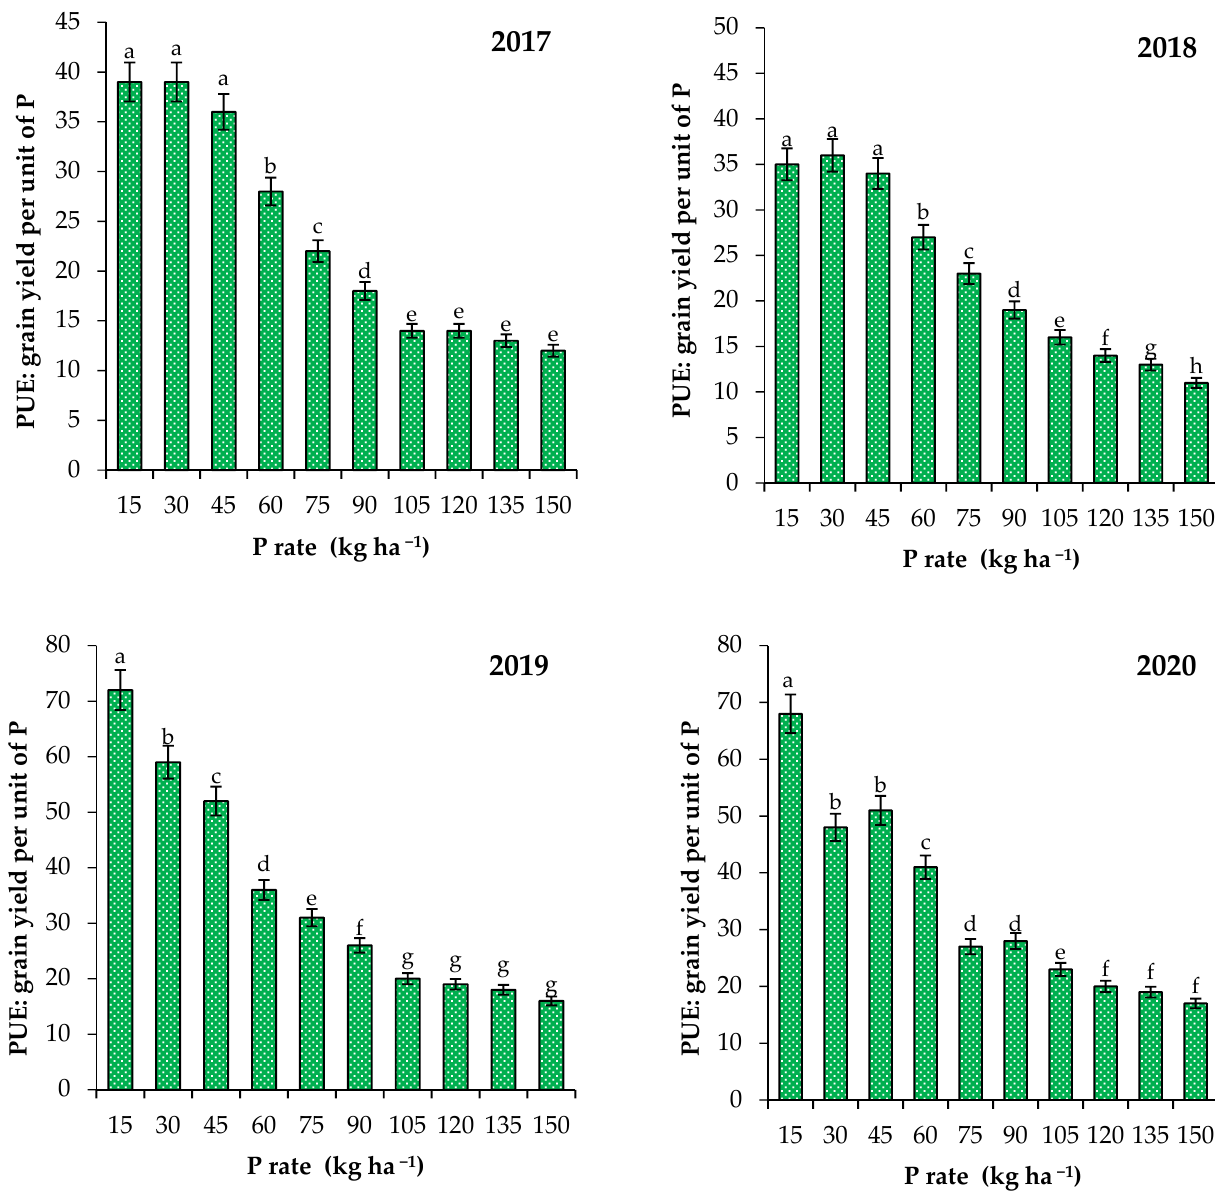
Figure 1. P use efficiency (PUE) as affected by fertilization rates during the four growing seasons (2017–2020). Means denoted by different letters indicate significant difference according to Duncan’s test at p <